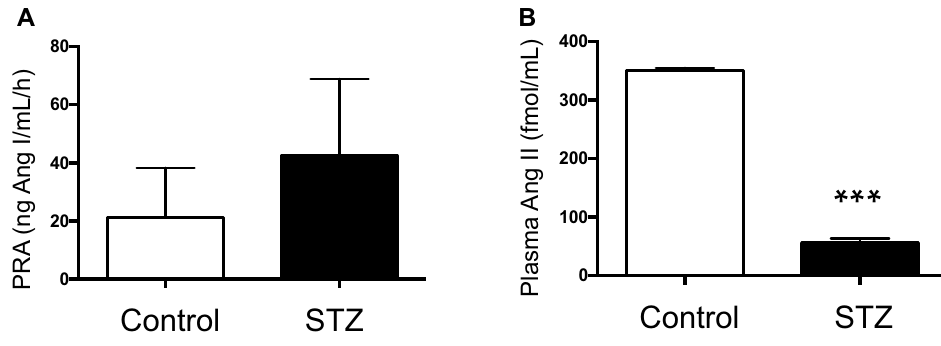
Figure 1. Changes in plasma renin and Ang II contents in streptozotocin (STZ)rats. Plasma renin activity ( A ) and plasma Ang II levels ( B ) in control (n = 7) and diabetic hyperglycemic rats (n = 9) induced by STZ administration for 7 d. *** P < 0.001 versus control group.